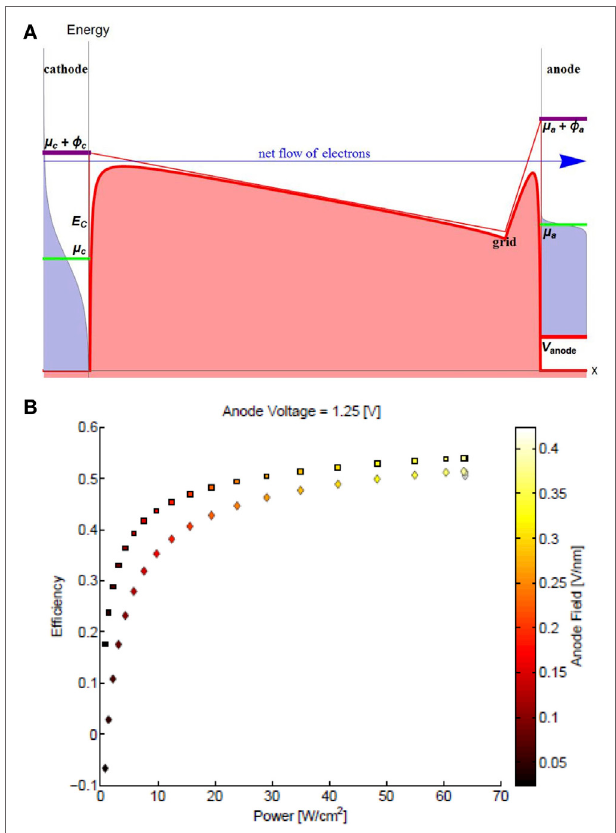
FigURe 6 | (A) Energy-level diagram of a single-collector-grid heat engine, where the hot side is a classical thermionic cathode emitter, and there is a strong electric field (preferably > 0.1 V/nm) applied on the collector. The red region depicts the potential energy landscape in the vacuum gap, shaped by the grid voltage. Cathode-emitted electrons with energies above-but-close-to the collector Fermi level (green line) can tunnel through the thin barrier setup by the electric field outside the collector, circumventing the collector work function (purple line). (B) Predicted power vs efficiency of single-collector-grid thermionic convertor that uses inverse tunneling of electrons at the electron collector, with temperatures T H = 1,500 K, T C = 300 K, work functions ϕ c = 2.0 eV, ϕ a = 1.5 eV, and a varying collector electric field < 0.4 V/nm. The lower curve corresponds to 1% grid loss. Reprinted, with permission, from Pan et al. (2014). Copyright 2014